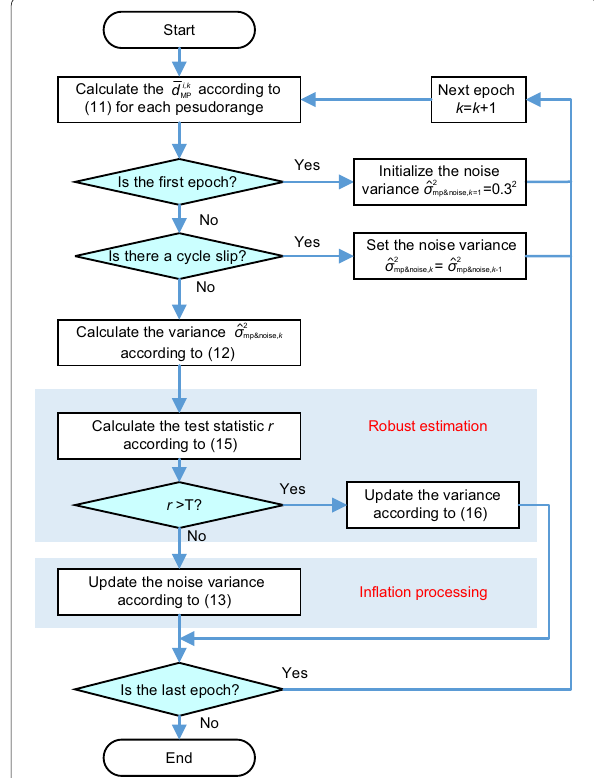
Fig. 1 The processing of real-time estimation of pseudorange variance